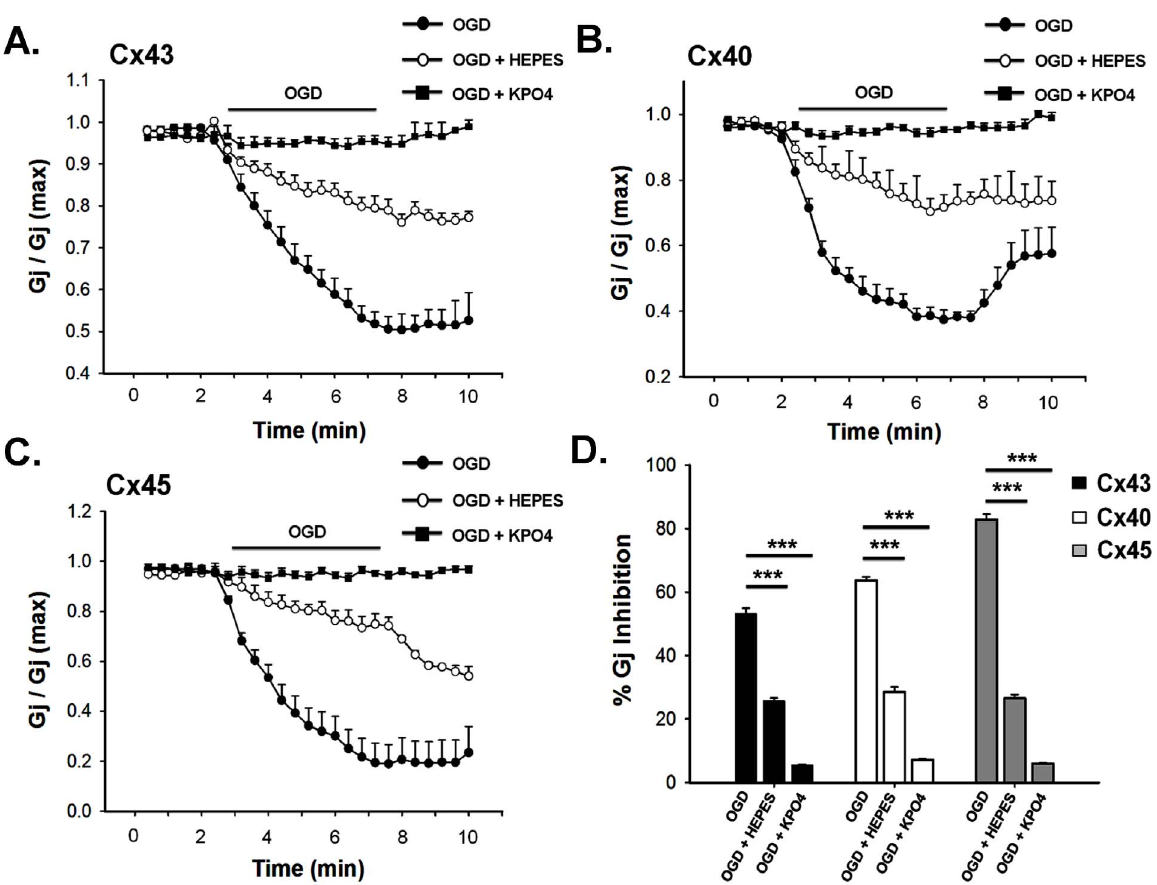
Figure 7. Restriction of intracellular acidification and calcium rise prevents OGD-induced uncoupling of gap junctions. Intracellular pH (pH i ) was maintained to 7.2 during OGD by adding 80 mM HEPES in the pipette solution. Clamping of pH i alone attenuated the reduction of Gj of all Cxs i.e. Cx43, Cx40 and Cx45 significantly (A, B and C) . But restriction of both [Ca 2 + ] i elevation and acidification by adding 150 mM potassium phosphate in the pipette solution prevented the uncoupling of all gap junctions completely (A, B and C) . D . statistical representation of data generated from 6–9 independent experiments. Values are the mean 6 SEM. ***, p , 0.001.